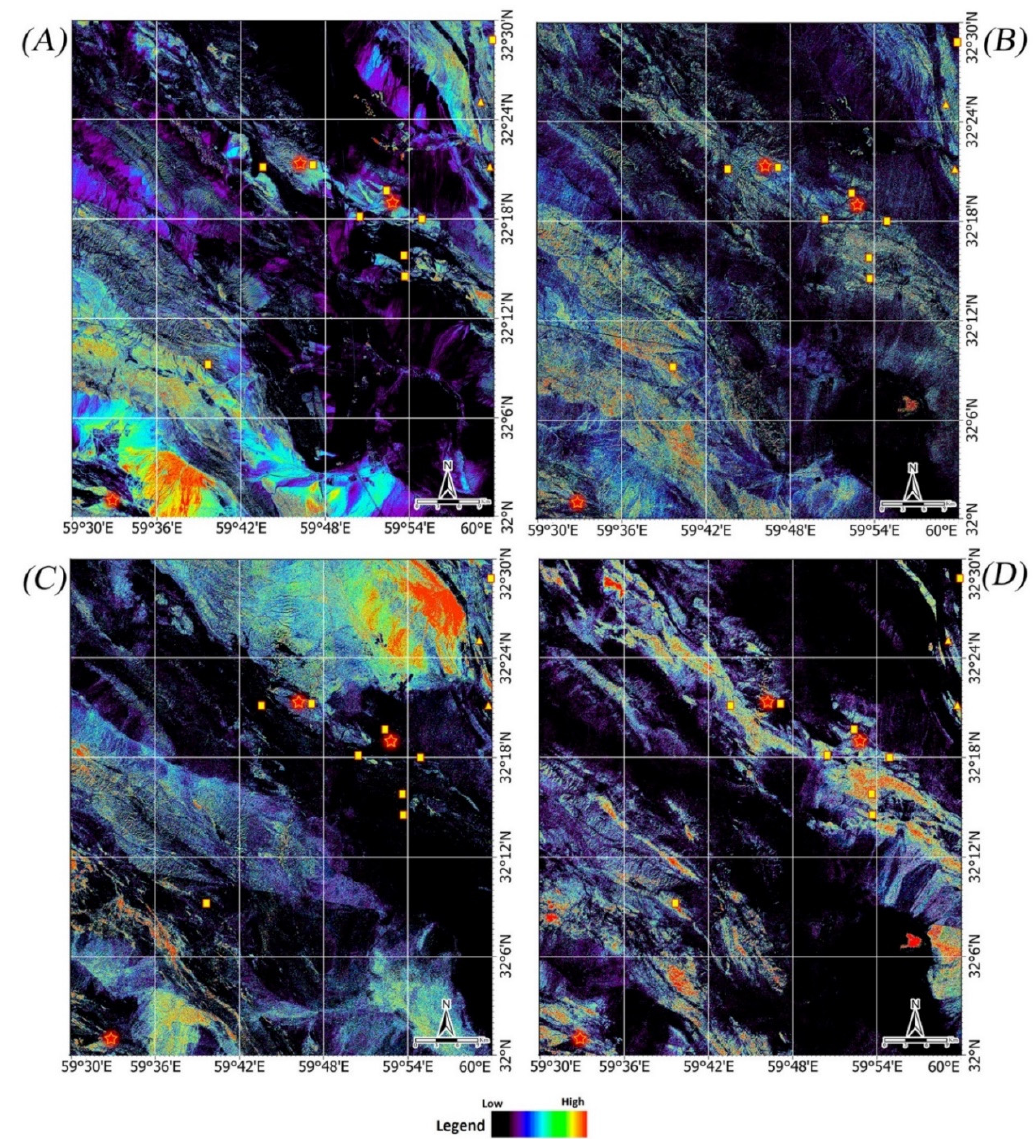
Figure 6. Pseudo-color ramp of band ratio results. ( A ) Band ratio of 4/2 shows the surface distribution of iron oxide/hydroxides; ( B ) band ratio of 5/6 shows the surface distribution of argillic alteration; ( C ) band ratio of 7/6 shows the surface distribution of phyllic alteration; ( D ) band ratio of 9/8 shows the surface distribution of propylitic alteration.